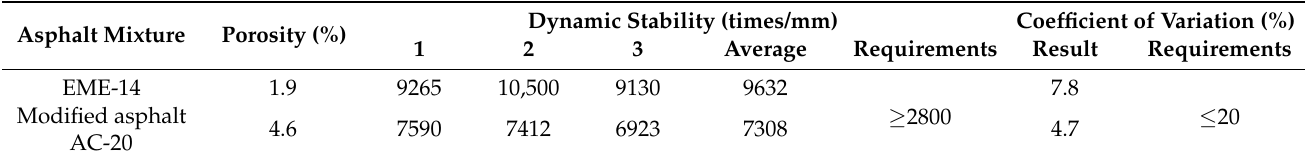
Table 8. Results of the Chinese wheel tracking test.